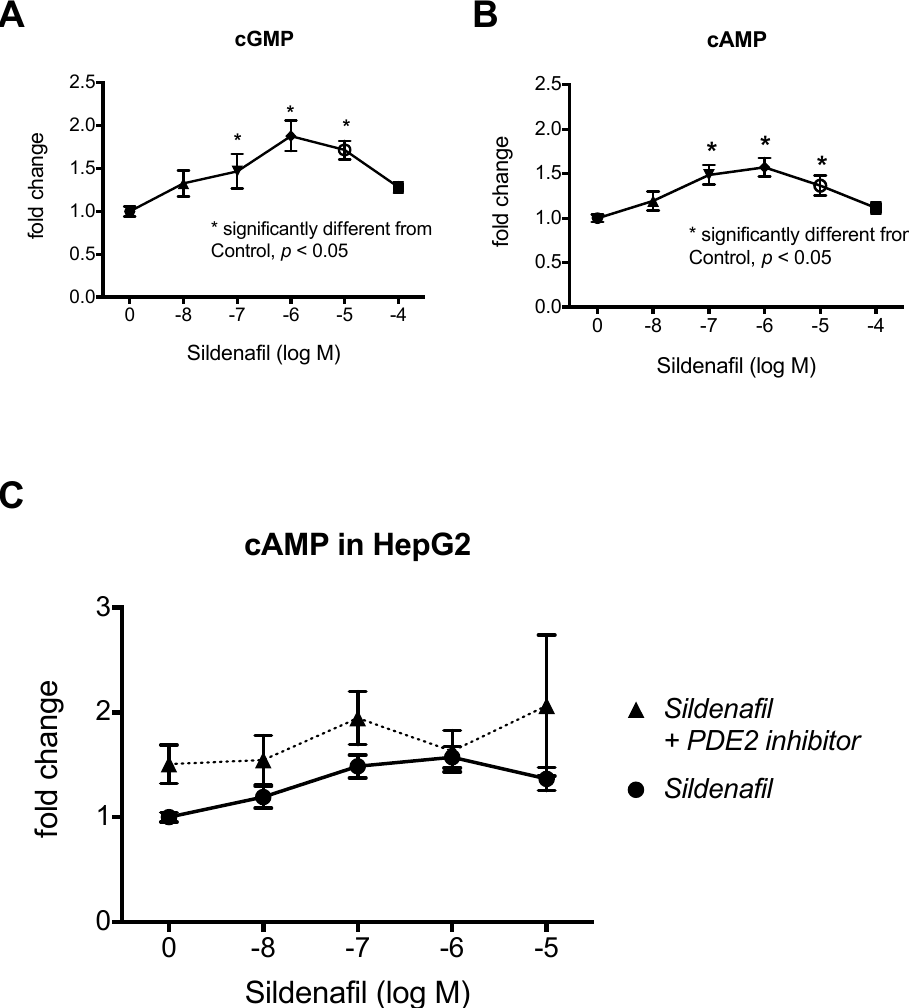
Figure 1. E ff ects of sildenafil on cGMP and cAMP concentrations in HepG2 cells. ( A ) Intracellular cGMP and ( B ) intracellular cAMP concentrations in HepG2 cells treated with sildenafil (10 nM to 100 µ M) for 30 min. Data were calculated and statistically analyzed as fold change of control and are expressed as means ± SEM ( n = 3 to 6, p ≤ 0.05) (absolute values for control means are 1.642 pmol cGMP / mg protein and 3.45 pmol cAMP / mg protein). ( C ) Comparison of cAMP response in HepG2 cells treated with sildenafil (10 nM to 10 µ M) +/ − PDE2 inhibitor (BAY 60-7550, 10 uM) for 30 min.